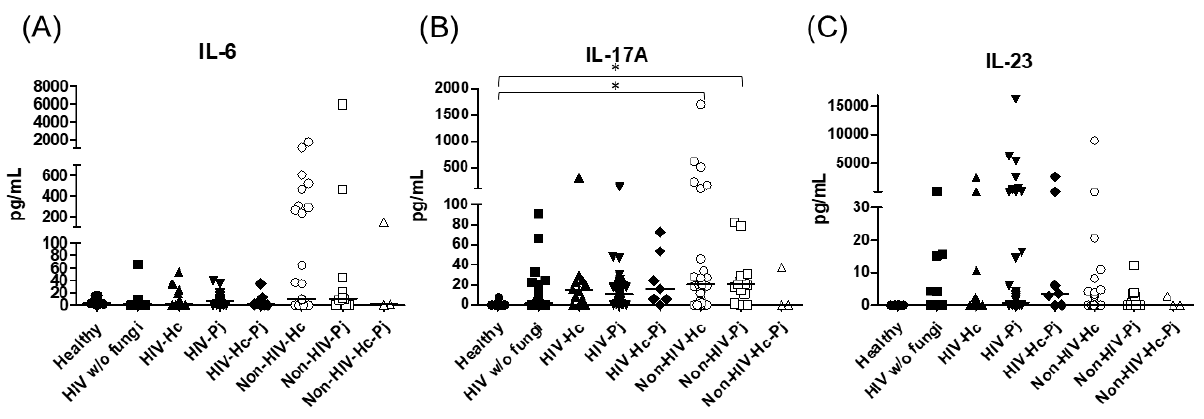
Figure 5. Determination of cytokines of the IL-17/IL-23 axis. IL-6, IL-17A, and IL-23 were detected by a cytometric bead assay in the BAL samples of hospitalized patients; results were obtained in pg/mL. Median values are shown for ( A ) Il-6, ( B ) IL-17A, and ( C ) IL-23. * p < 0.05. Regarding the anti-inflammatory cytokine IL-10, results showed low values in most groups, although no statistical differences were found (Figure